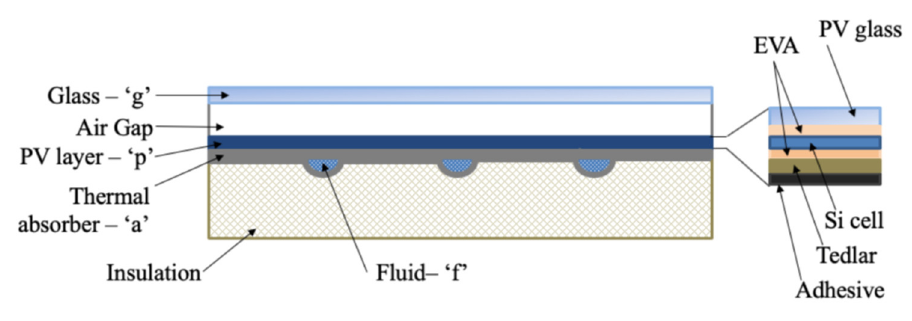
Figure 3. PVT cross section [25].